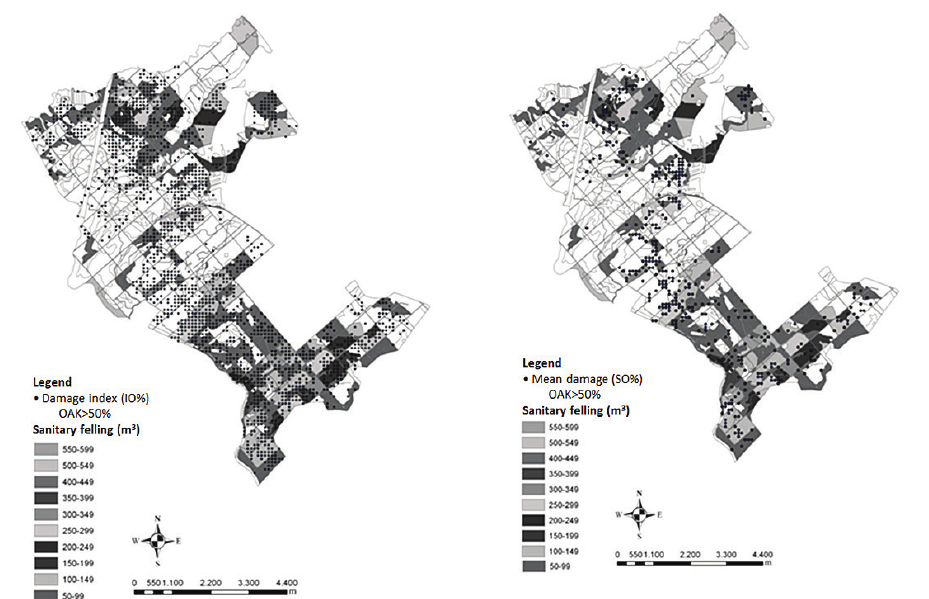
FIGURE 7. Spatial distribution of damaged trees and snags and sanitary